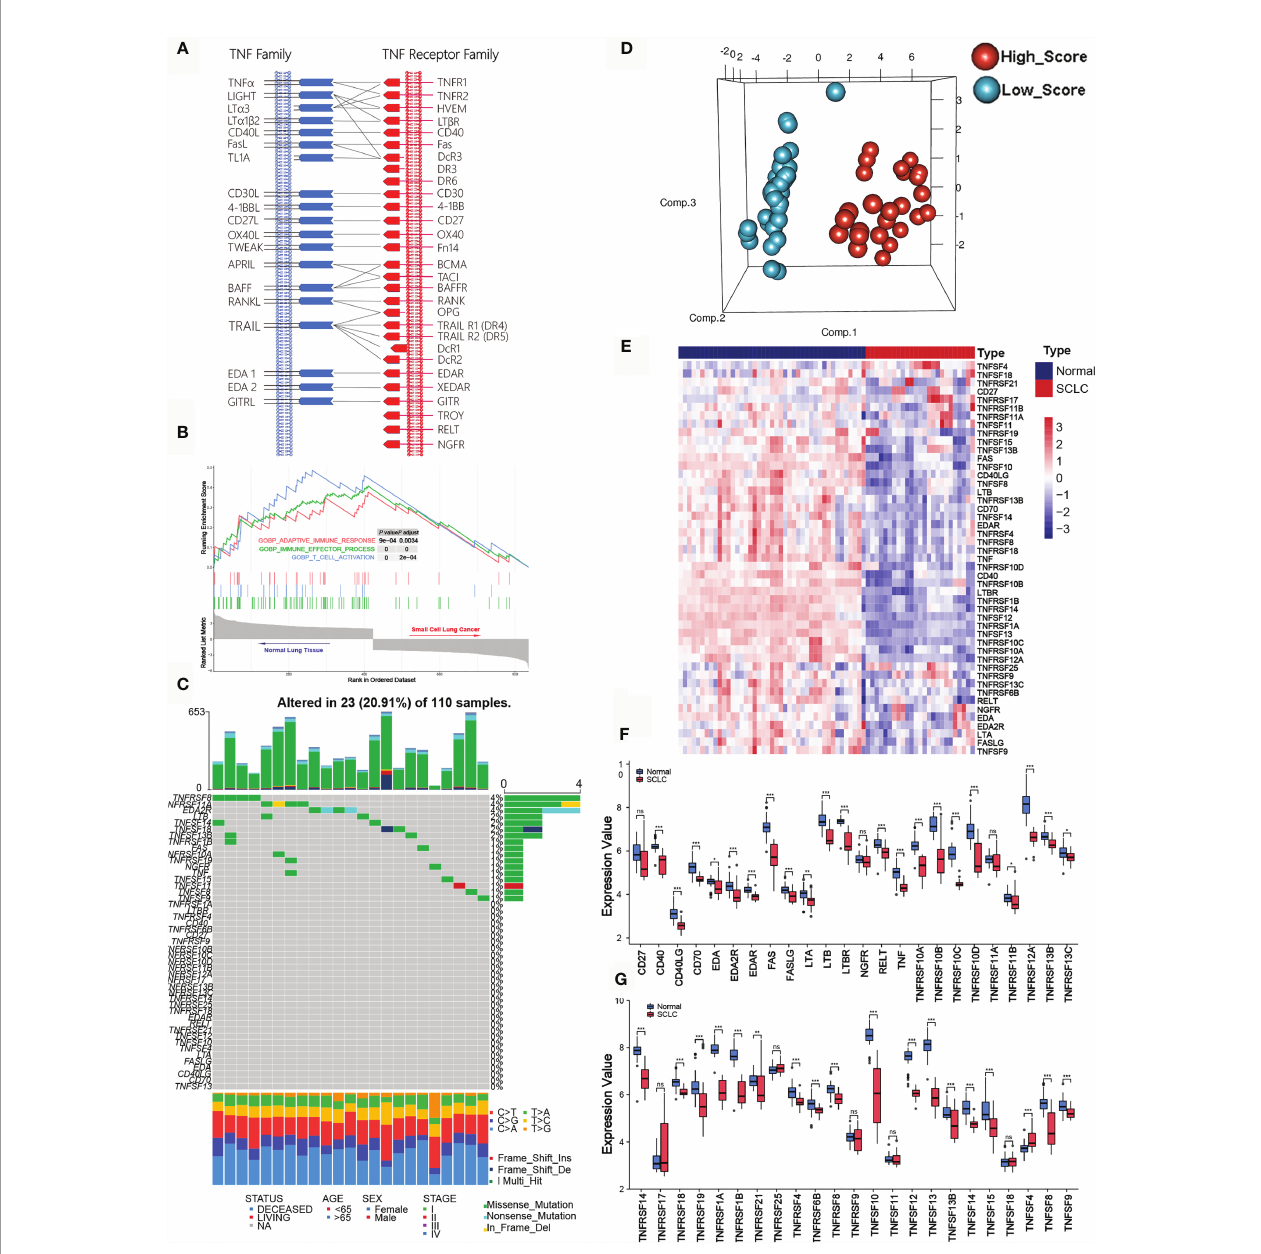
FIGURE 1 | Molecular characteristic and expression pro fi le of tumor necrosis factor (TNF) family members in small cell lung cancer. (A) Interaction between the ligands and receptors of the TNF family. Ligands and receptors are shown at the left (blue) and right (red) in the diagram. The vertical lines represent the cytoplasmic membrane of corresponding cells, and the horizontal lines with arrows represent ligand-receptor pairs. (B) GSEA of normal lung tissues and SCLC tissues. (C) The mutation landscape waterfall plot of TNFSF/TNFRSF members in 110 patients with SCLC from the training cohort. Each bar represents the mutation for each sample. (D) Principal component analysis (PCA) based on the expression levels of TNF family members between adjacent normal tissue and tumor tissue in the training set. (E) The expression details of TNF family members between SCLC samples and normal lung tissue. (F, G) Boxplots show differences in the expression values of TNF family members. *p < 0.05; **p < 0.01; ***p < 0.00; ns, no signi fi